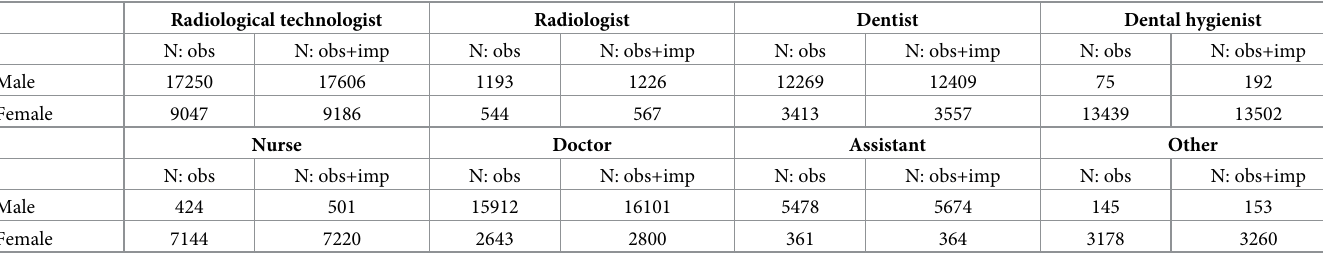
Table 1. The contingency table of sex and type of job. Radiological